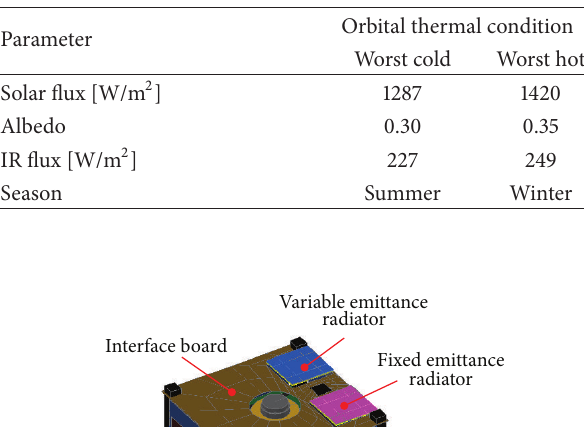
Table 4: Orbital thermal condition for the worst case thermal analysis.